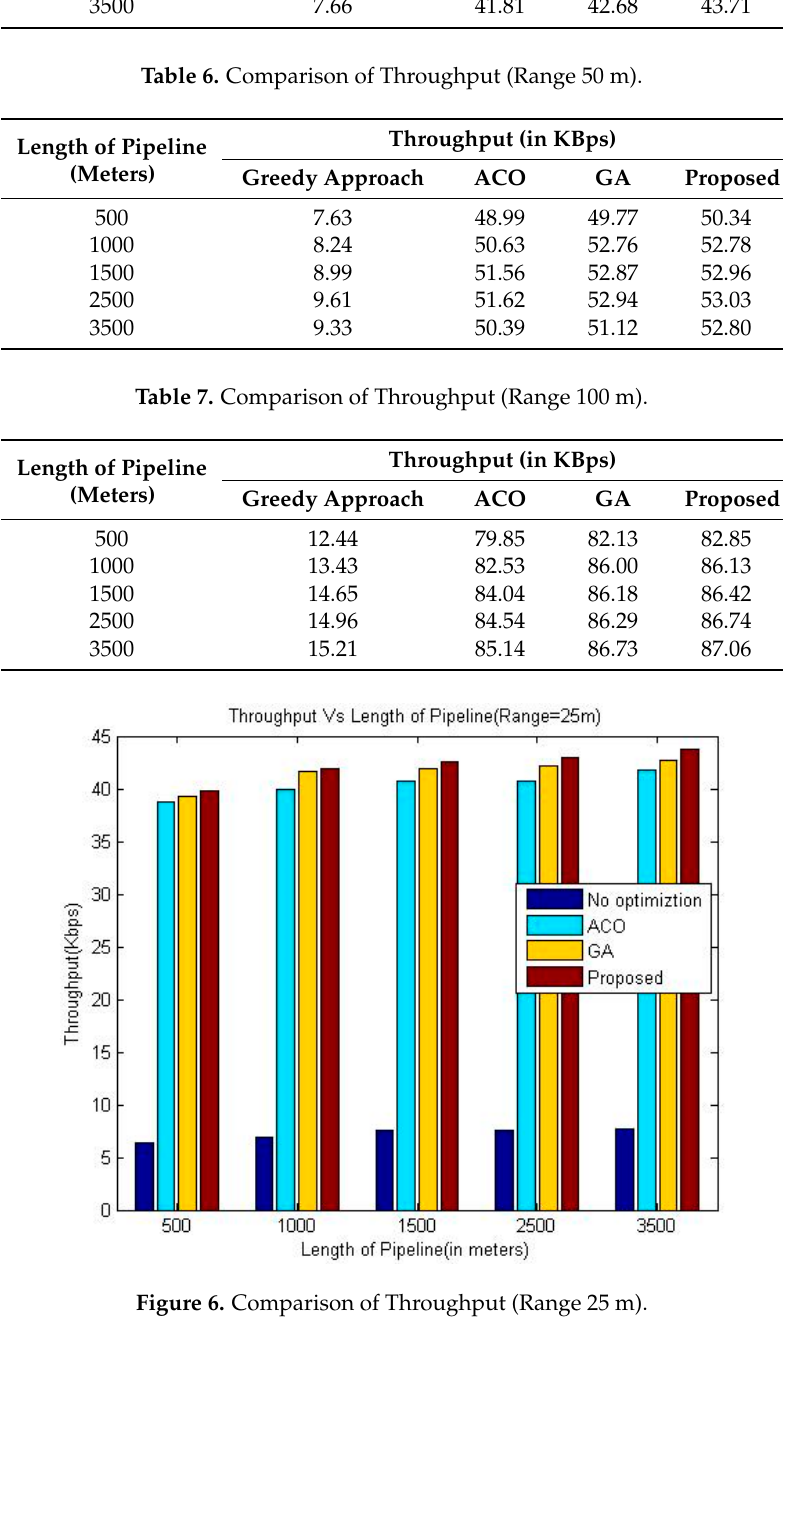
Figure 7. Comparison of Throughput (Range 50 m). Figure 8. Comparison of Throughput (Range 100 m).